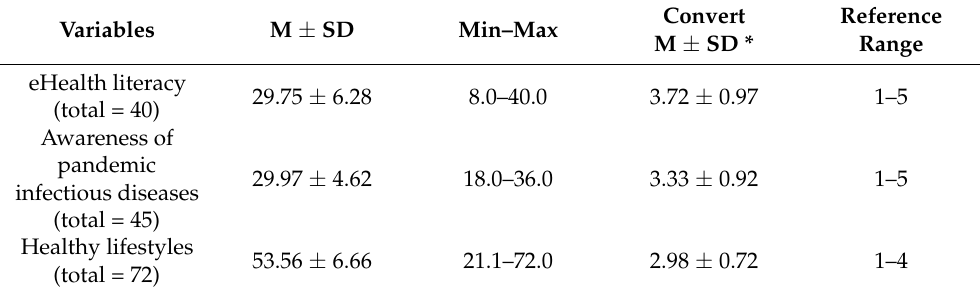
Table 2. The degrees of eHealth literacy, awareness of pandemic infectious diseases, and healthy lifestyles of middle school students. (n =